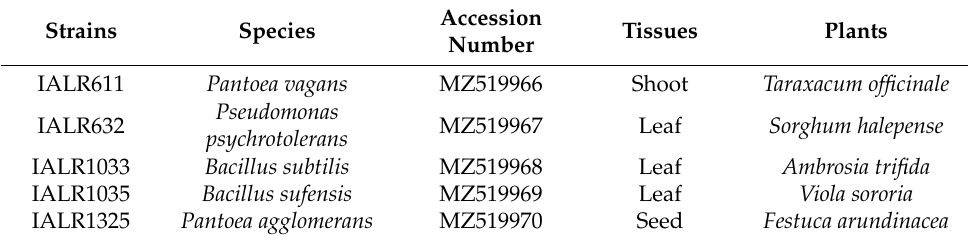
Table 1. Origination and identification of the phosphate solubilizing